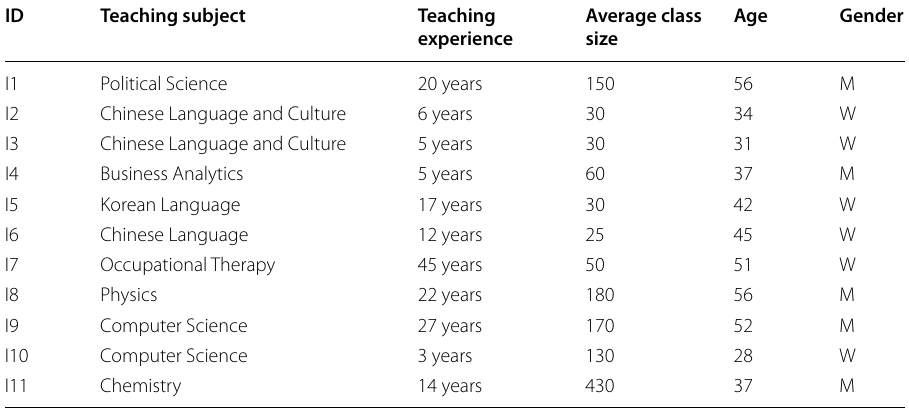
Table 4 Summary of the instructors’ information